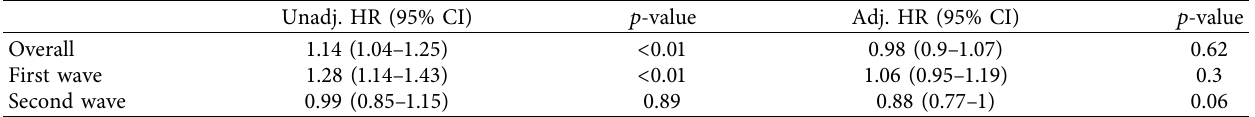
Table 3: Mortality analysis with 2 or more risk